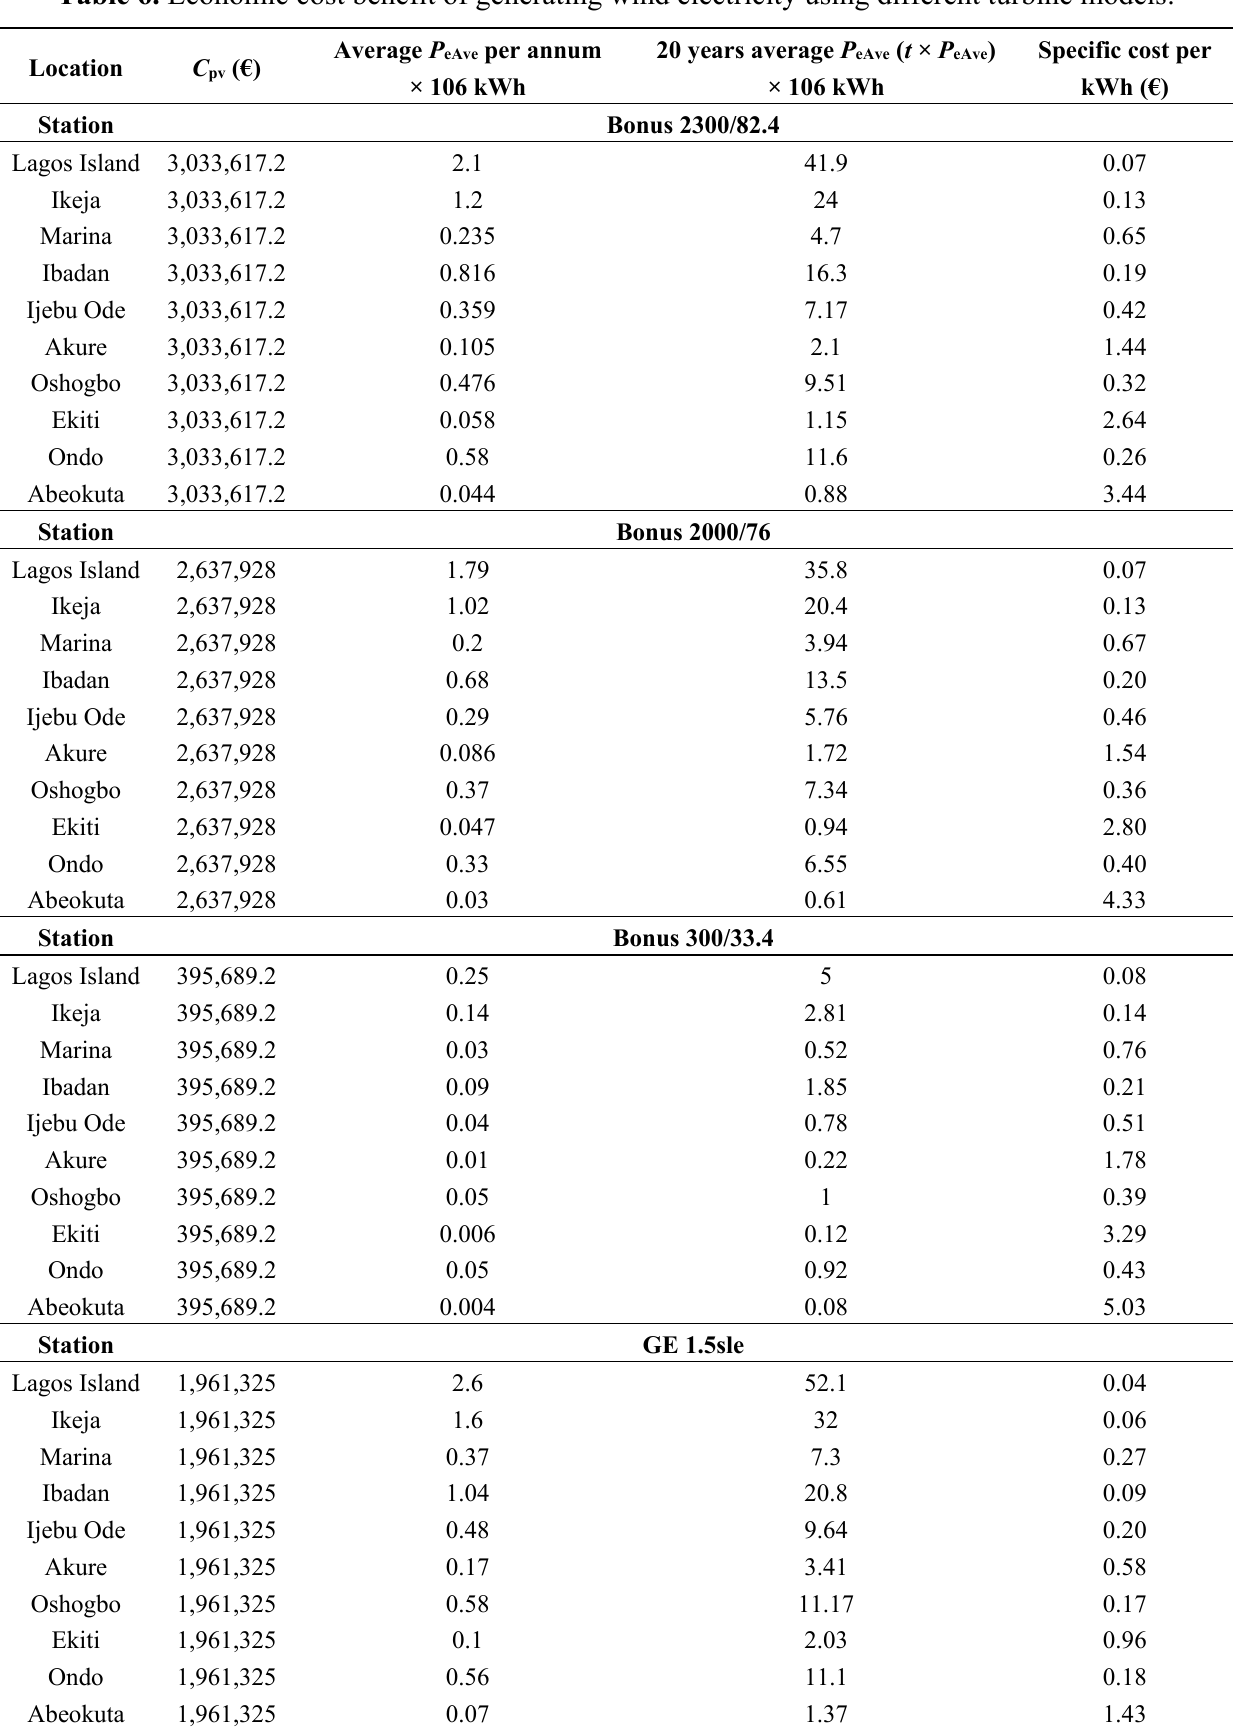
Table 6. Economic cost benefit of generating wind electricity using different turbine models.